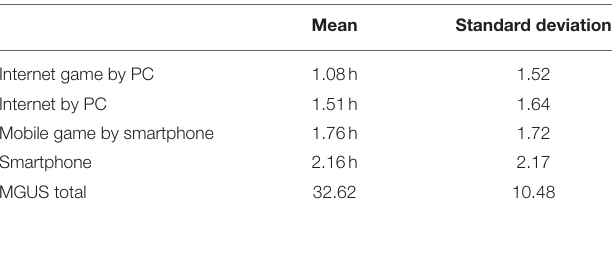
TABLE 1 | Descriptive statistics of usage time and problematic game usage.